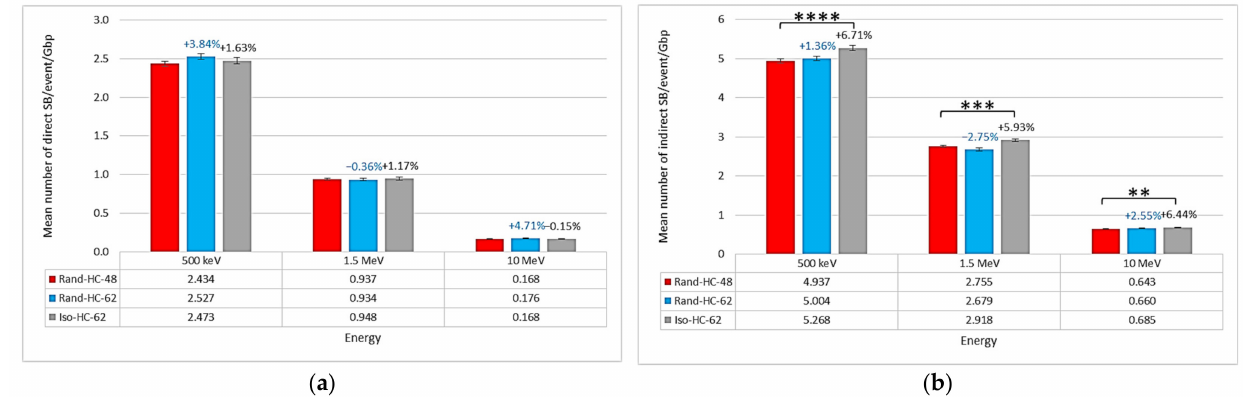
Figure 3. For the three endothelial geometries (Rand-HC-48, Rand-HC-62, and Iso-HC-62) irradiated with protons at different energies, comparison of the mean number of ( a ) direct SBs/event/Gbp and ( b ) indirect SBs/event/Gbp. For the Rand-HC-62 and Iso-HC-62 nuclei, the figures above the bars indicate the relative increase compared to the Rand-HC-48 nucleus in mean number of ( a ) direct SBs/event/Gbp and ( b ) indirect SBs/event/Gbp. Asterisks above the bars represent the degree of confidence on the difference between the two related mean values assessed by Student’s t -test (** p < 0.01, *** p < 0.001, **** p <